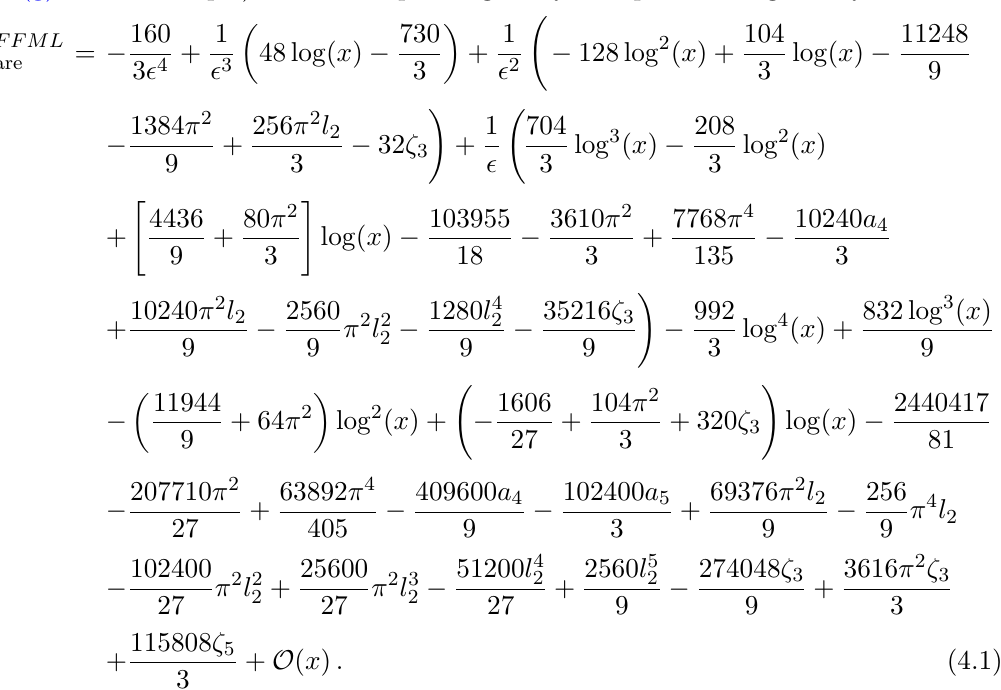
logarithmic divergences which arise from diagrams containing a fermion self energy